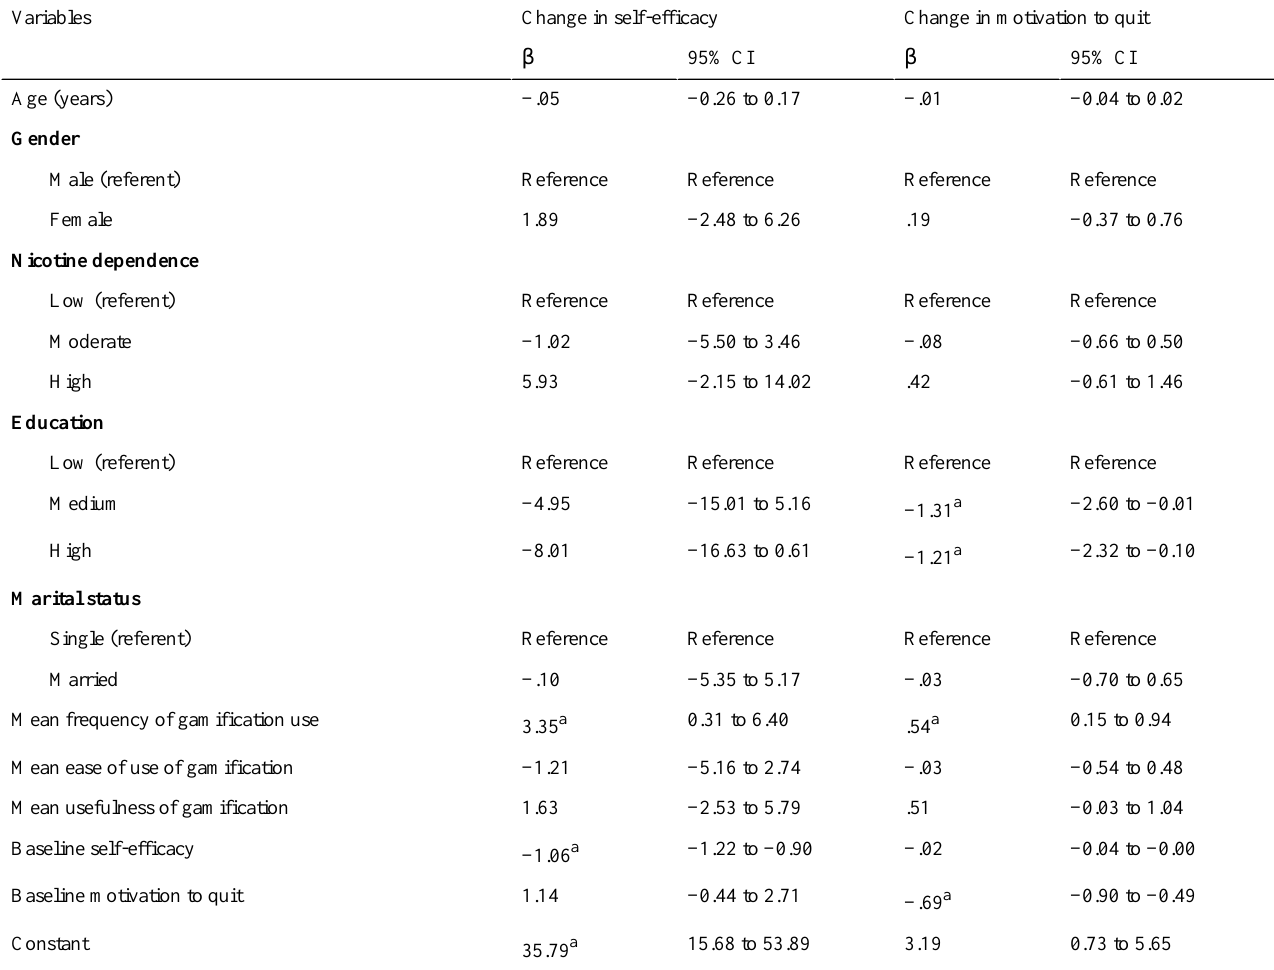
Table 3. Linear regression model examining the association between perceived usefulness, ease of use, and frequency of use of gamification features with change in self-efficacy and change in motivation to quit